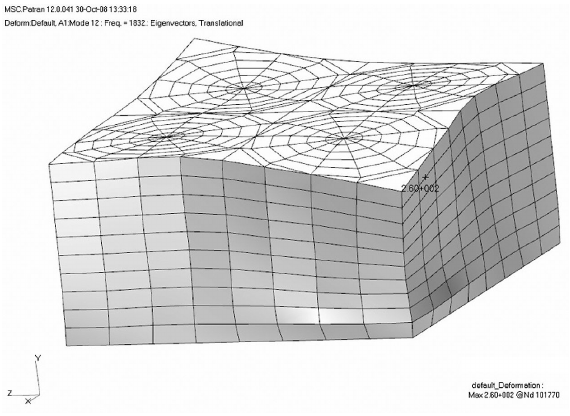
Fig. 24. 12th and 13th mode: 1832 Hz.